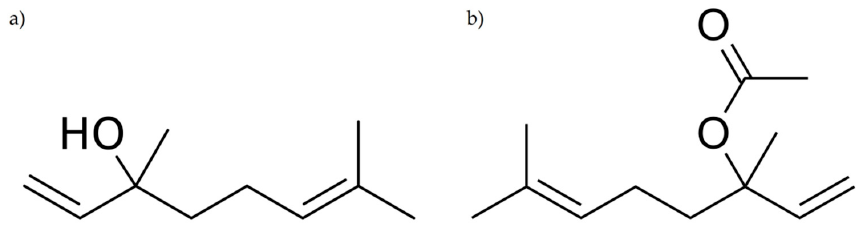
Figure 1. The chemical structures of the main compounds of lavender essential oil: linalool ( a ) and linalyl acetate ( b ). Table 1. Chemical composition of volatile constituents of commercial lavender essential oil from the flowering herb of Lavandula angustifolia Mill. ( Lamiaceae ).